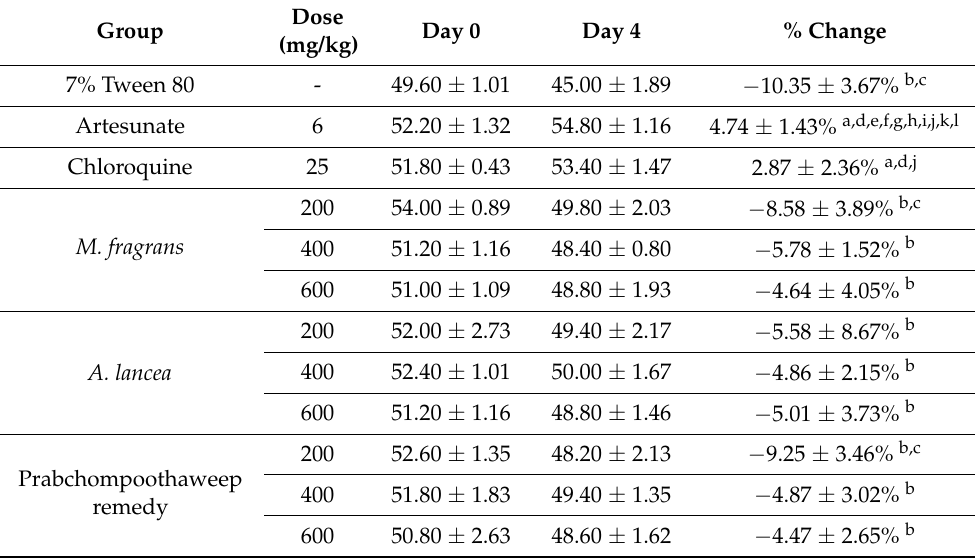
Table 6. Effect of ethanolic extracts of M. fragrans , A. lancea , and Prabchompoothaweep remedy on pack cell volume in the 4-day suppressive